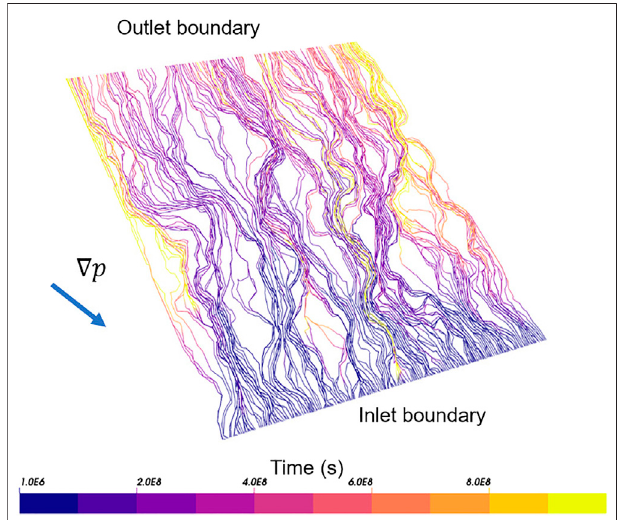
FIGURE 2 | Pathlines from ConnectFlow transport simulation in plane- projectedrepresentation,coloredbytraveltime.Directionofpressuregradient with respect to inlet and outlet boundaries is